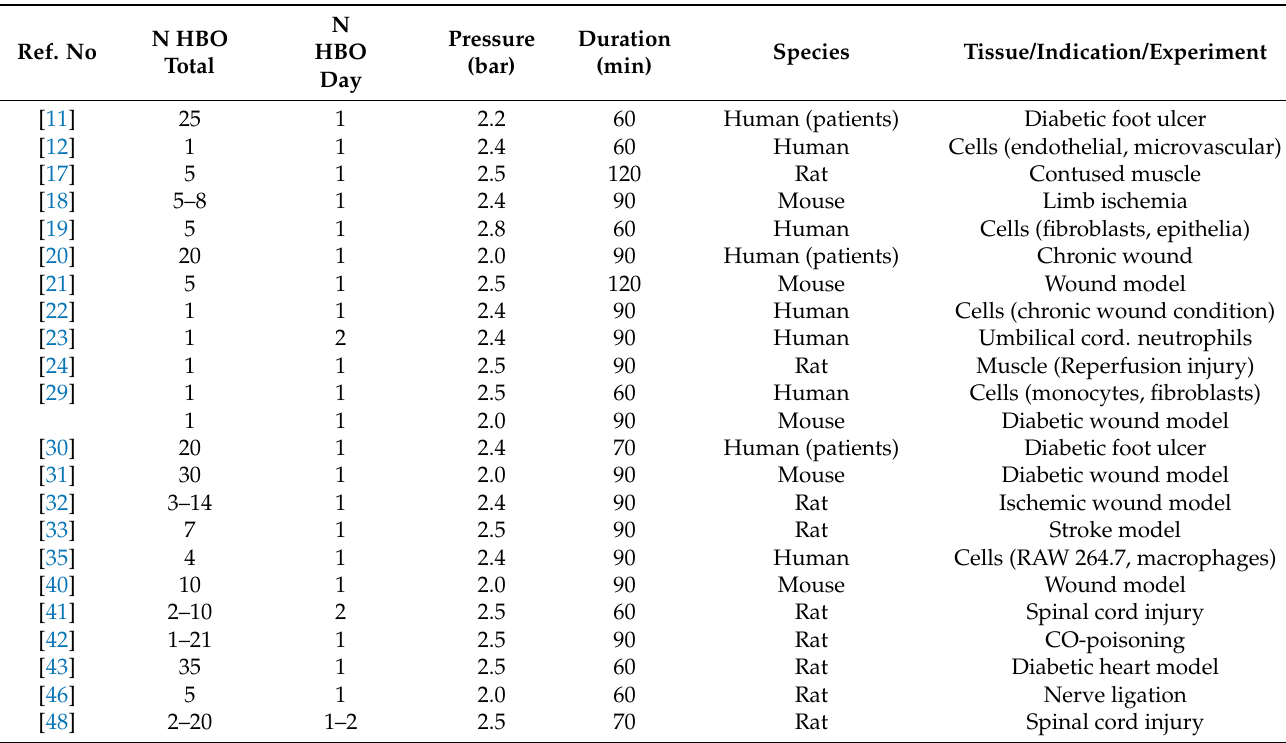
Table 2. Hyperbaric protocols, type of